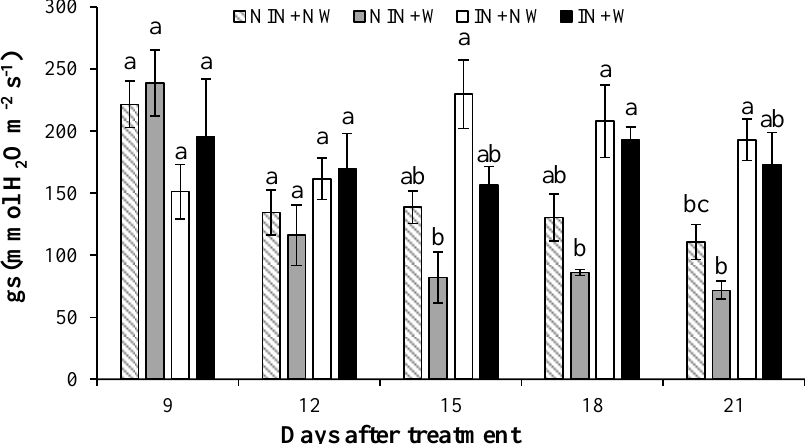
Figure 1. Stomatal conductance in R. sativus under waterlogged conditions and inoculated with A. brasilense . Averages followed by different letters at each sampling point show statistical differences according to Tukey’s test ( p < 0.05). Vertical bars in each average indicate standard error ( n = 11).